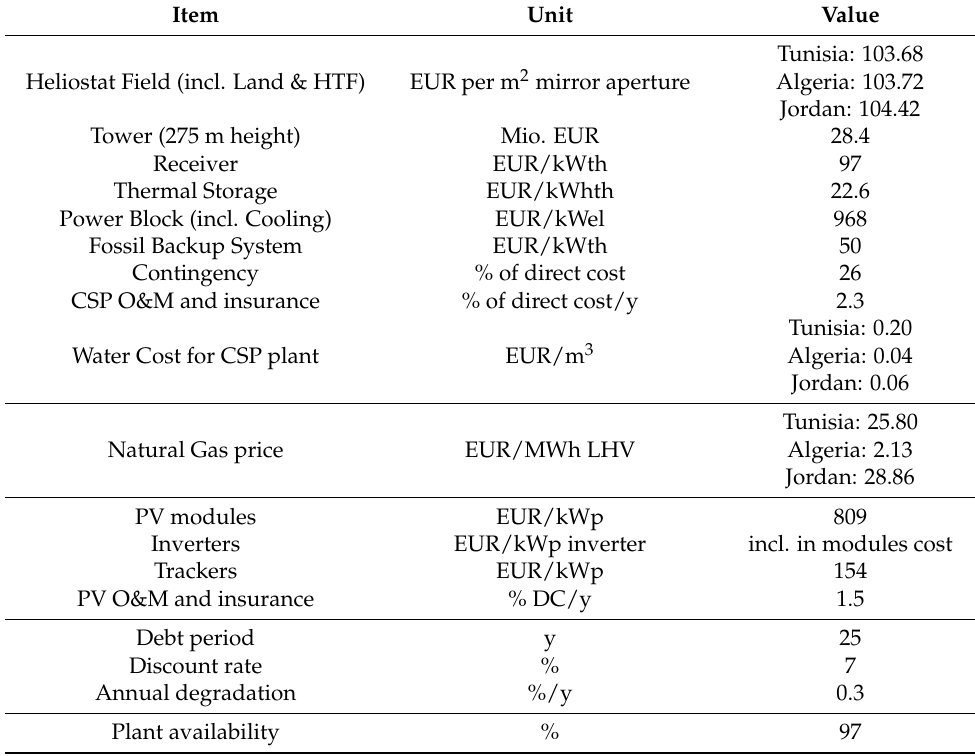
Table 4. Main economic data for CP3.